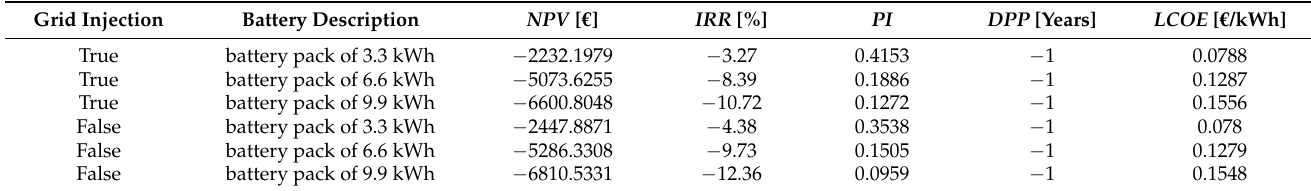
Table 13. Economical results for 3.45 kWp PV setup (individual battery